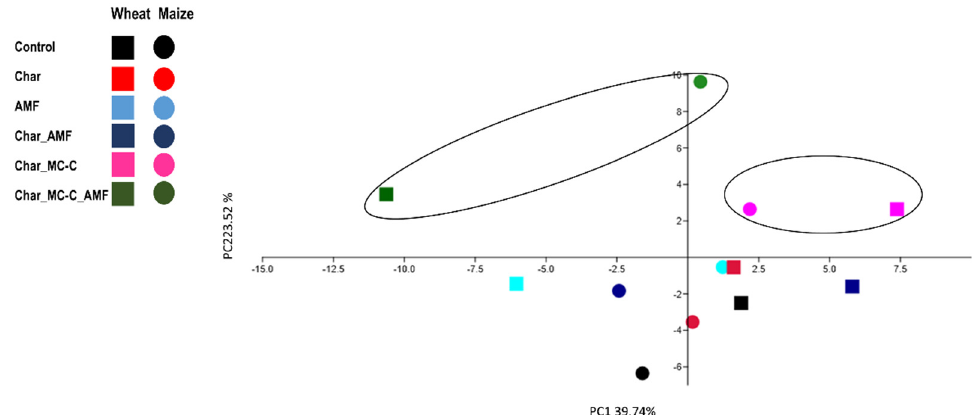
Figure 5. PCA analysis obtained with phenotypic and molecular (gene expression) data in the six growth conditions common to both wheat and maize plants (treatments and control). The black circles indicate the main grouping.